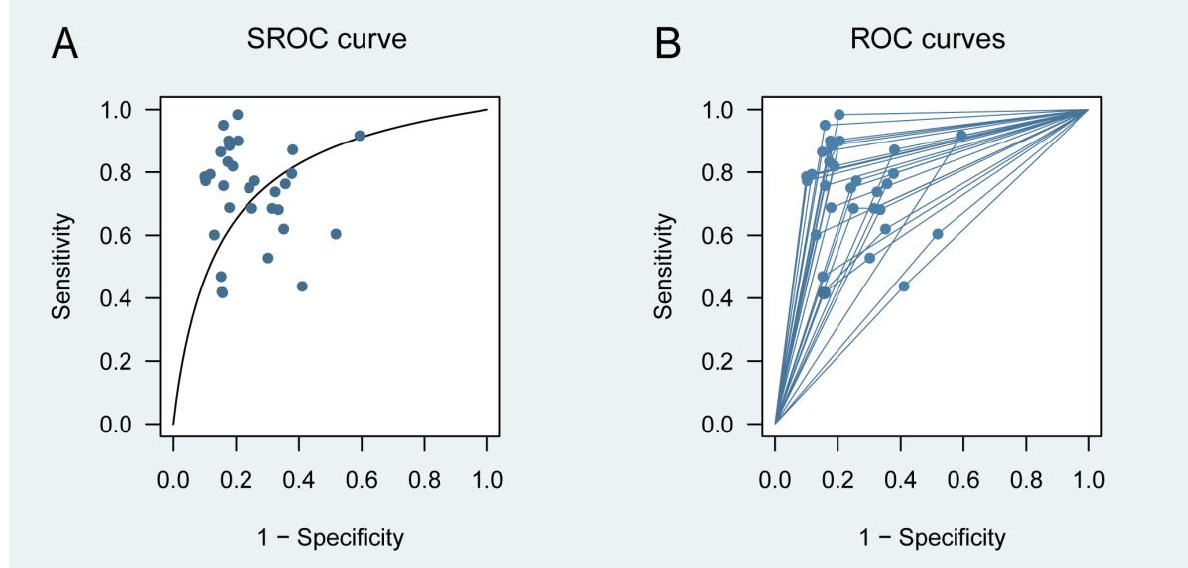
Figure 3. Test performance for predicting relapse in patients with IBD. ( A ) Multiple threshold SROC curve; ( B ) multiple threshold ROC curves based on the multiple thresholds model. Circles represent information on sensitivity and specificity. ROC, receiver operating characteristic; and SROC, summary receiver operating characteristic.